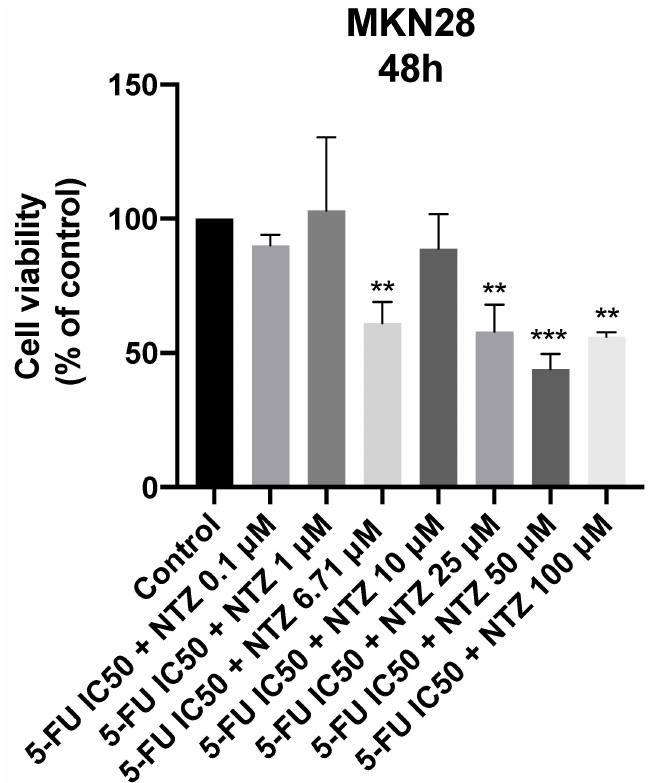
Figure 11. Cell viability of MKN28 cells treated with the combination of 5-FU and nitazoxanide. Values are expressed as percentages of control and represents means ± SEM. Each experiment was done three times independently ( n = 3); ** statistically significant vs. control at p < 0.01; *** statistically significant vs. control at p <